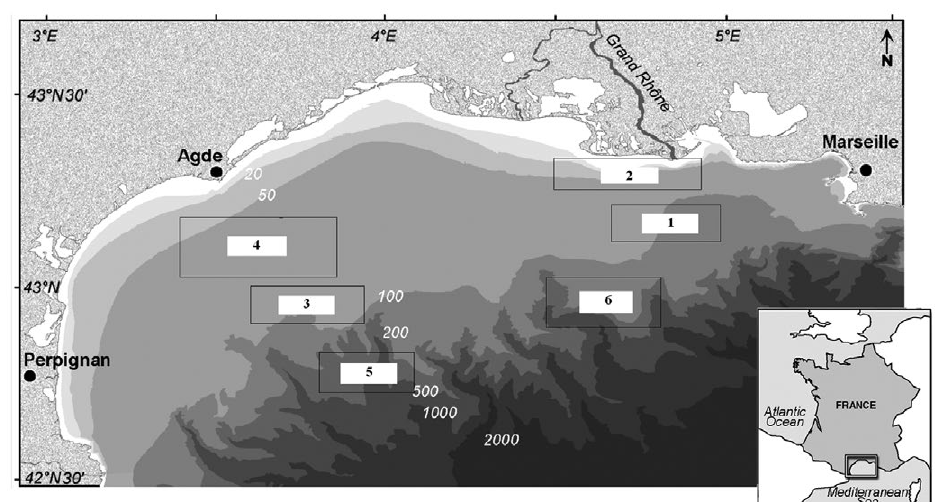
Fig. 1. – Map showing the location of sampling zones (hake and prey, 2004-2006) in the Gulf of Lions (box) in southern